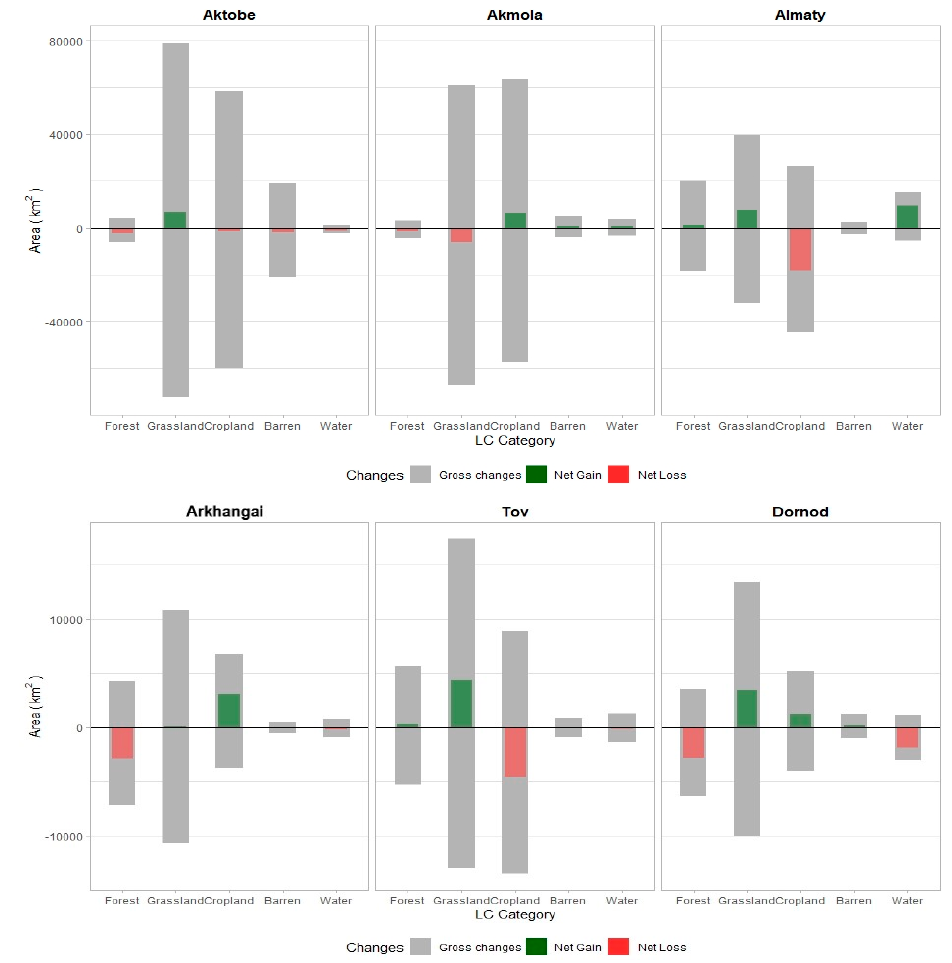
Figure 4. Gross and net changes of five land cover classes in six provinces in Kazakhstan and Mongolia from the 1990s to the